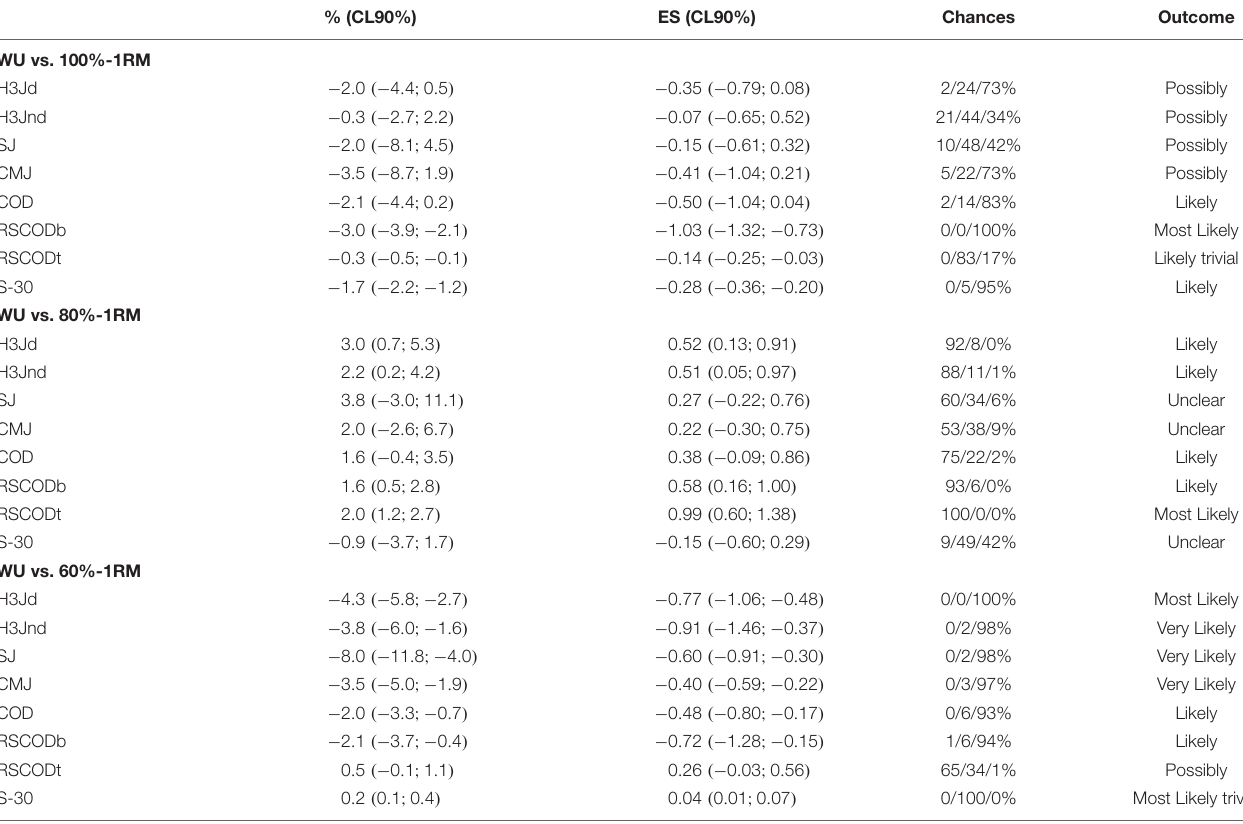
TABLE 2 | Comparisons of soccer player’s physical performance after a traditional (control) warm-up versus three different warm-up conditions. % (CL90%) ES (CL90%) Chances